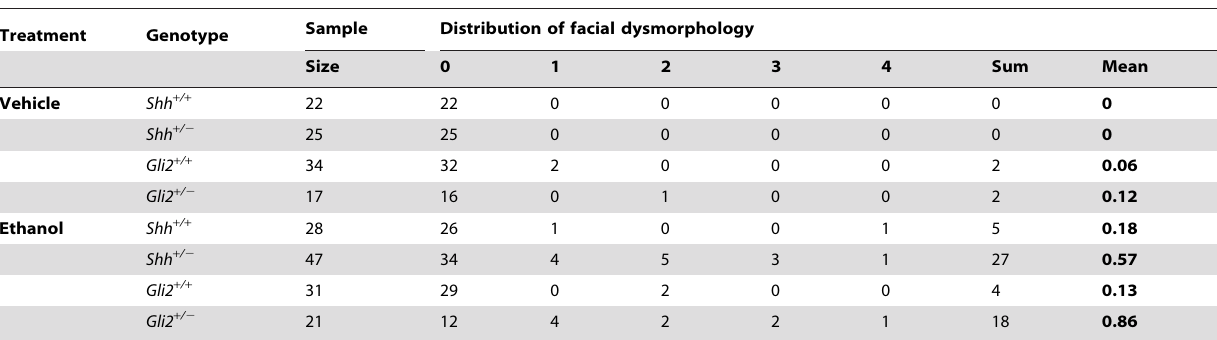
Table 1. Facial dysmorphology scores by treatment and